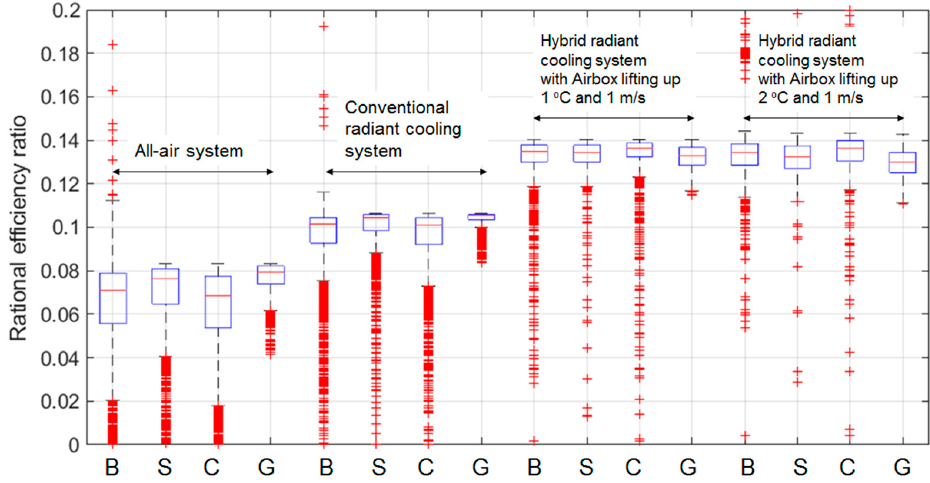
Figure 9. Rational exergy efficiencies of the three cooling systems in four cities: B—Beijing, S—Shanghai, C—Chengdu, and G—Guangzhou.